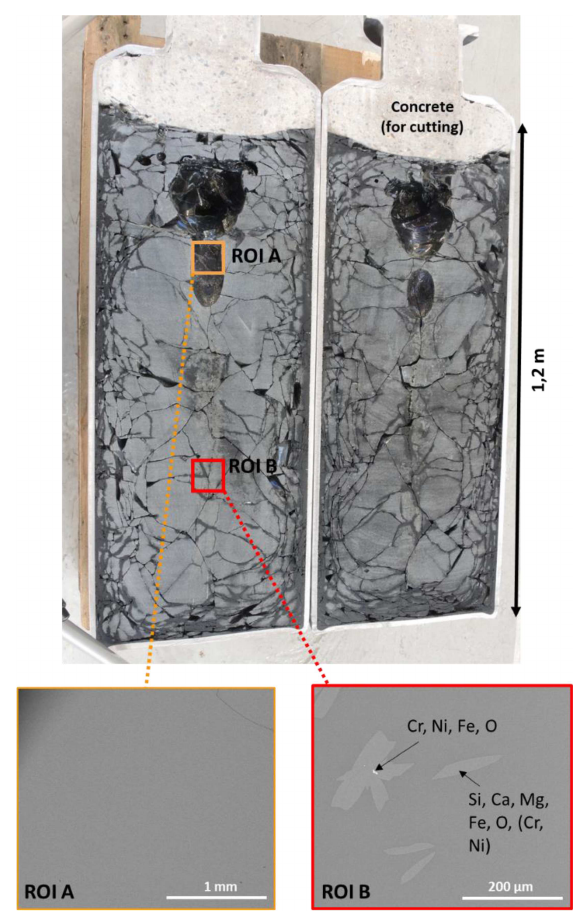
Fig. 8. Half-cut container obtained after vitrification of ALPS slurries using DEM&MELT prototype (WL ox = 40 wt.%) and SEM pictures of its